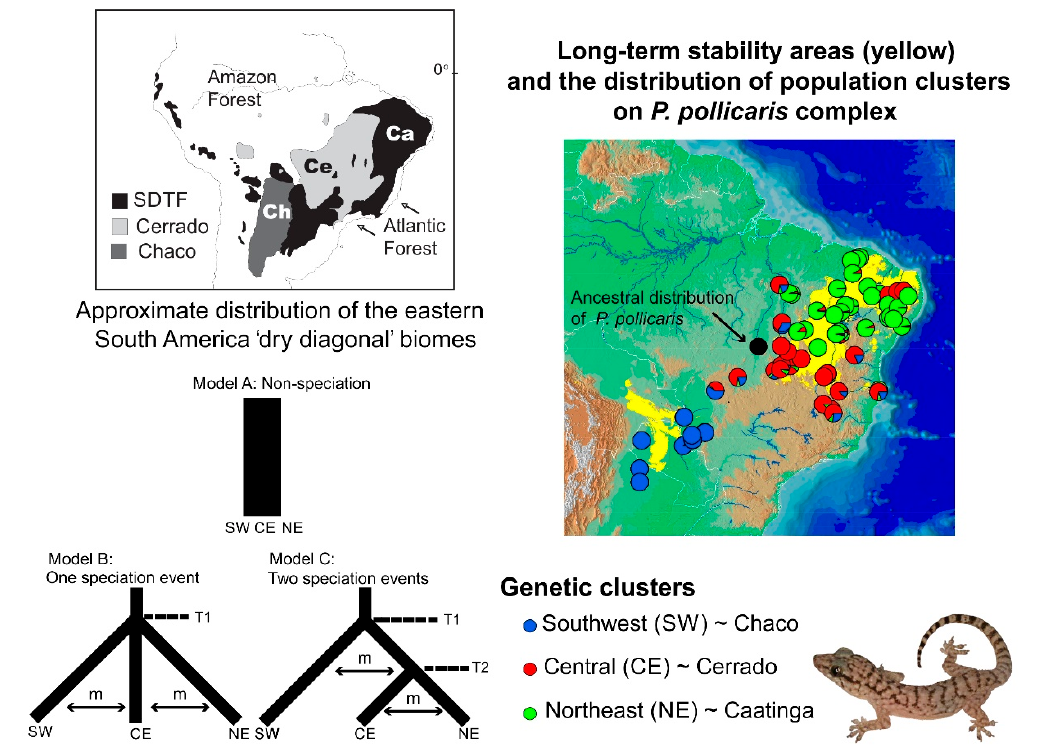
Figure 1. The distribution of the eastern South America dry diagonal biomes (top left) and the distribution of inferred Bayesian population clusters and ancestral distribution of P. pollicaris with respect to the inferred historical stability surface in yellow (stable areas obtained by overlapping predicted logistic outputs under four climatic scenarios: Current, 6, 21, and 120 kyr BP) and a digital elevation model for South America (brown represents higher altitudes). The pie charts represent the posterior probability that a given individual is assigned to a particular cluster. Alternative divergence models tested using an approximate Bayesian computation (ABC) framework (bottom left). STDF—Seasonal Tropical Dry Forest, T1—early divergence event, T2—recent divergence event, m—empirical relative mutation rates. Adapted from Werneck et al. (2012 [310]).